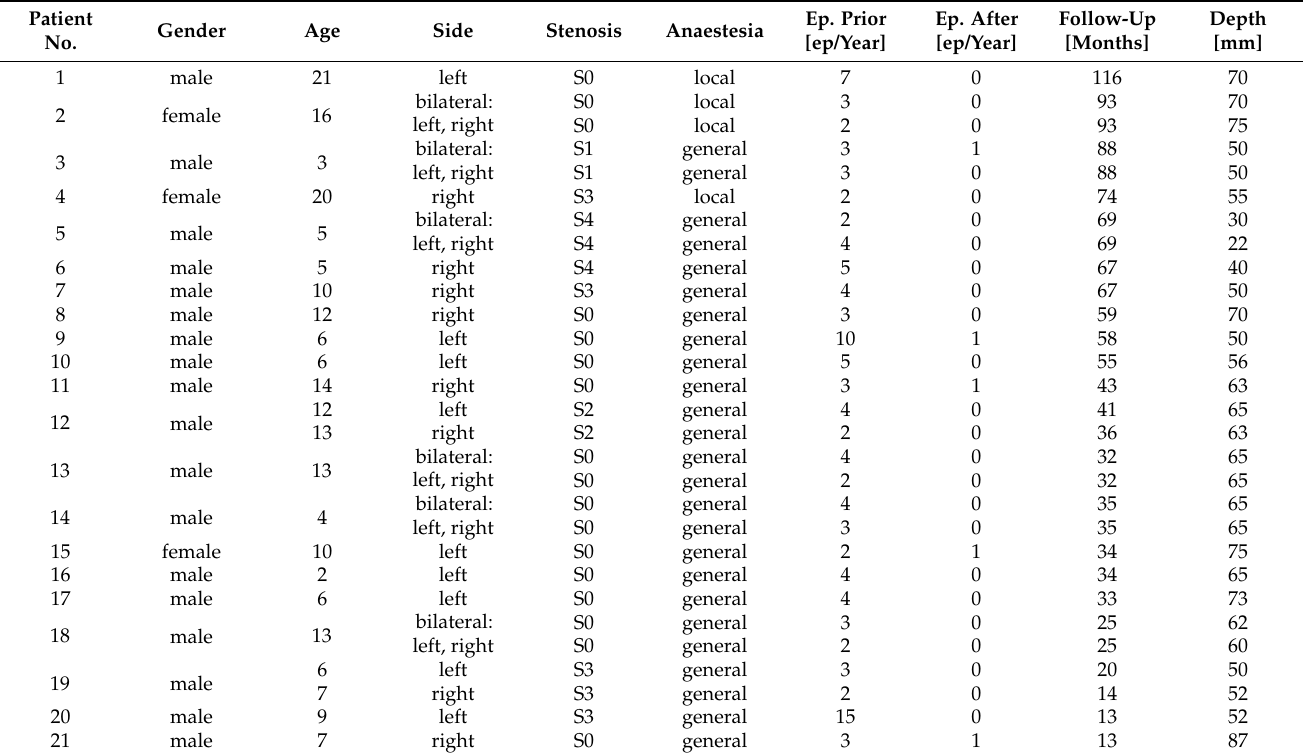
Table 1. Demographic, clinical, and therapeutic data of children included in this